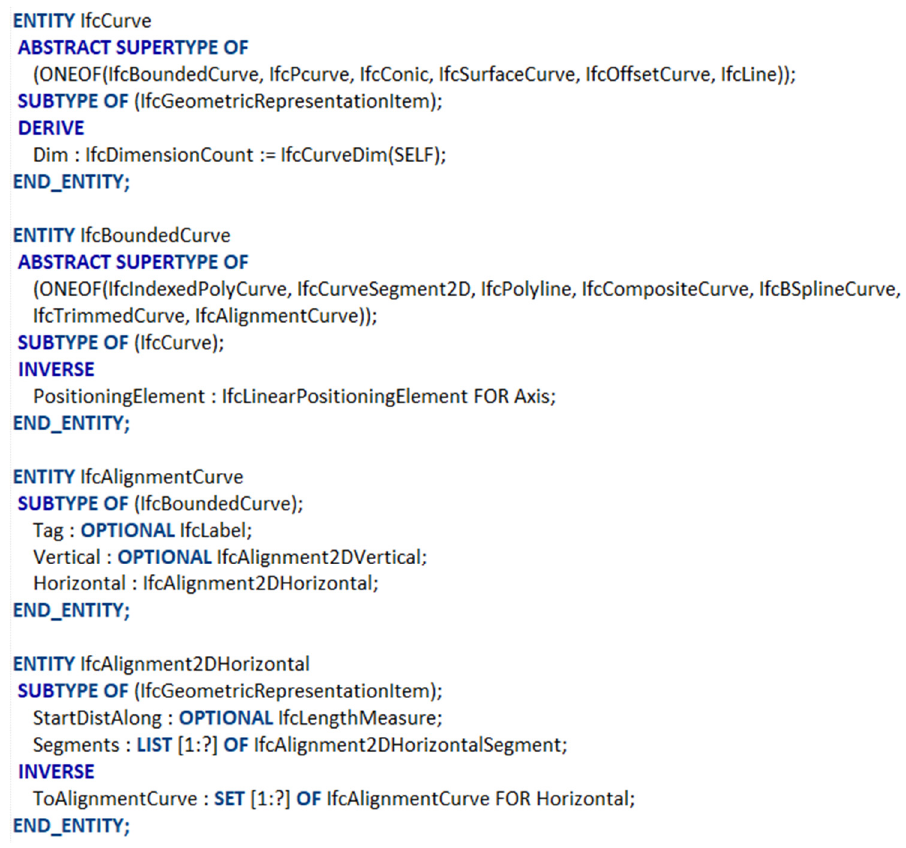
Figure 20. Selected declarations from the derived EXPRESS schema files.